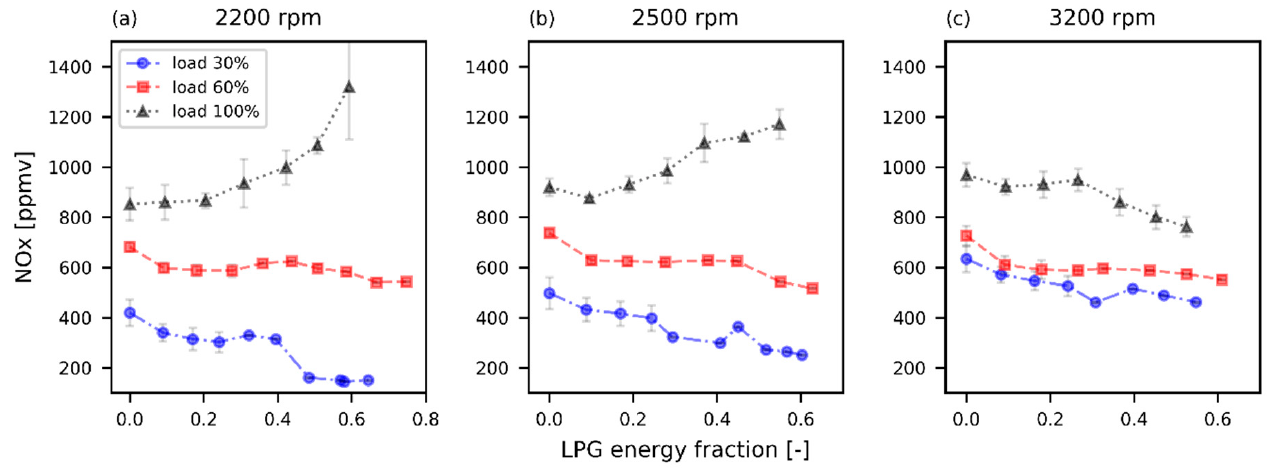
Figure 9. NOx emissions v / s LPG energy fraction at ( a ) 2200 rpm, ( b ) 2500 rpm, and ( c ) 3200 rpm.